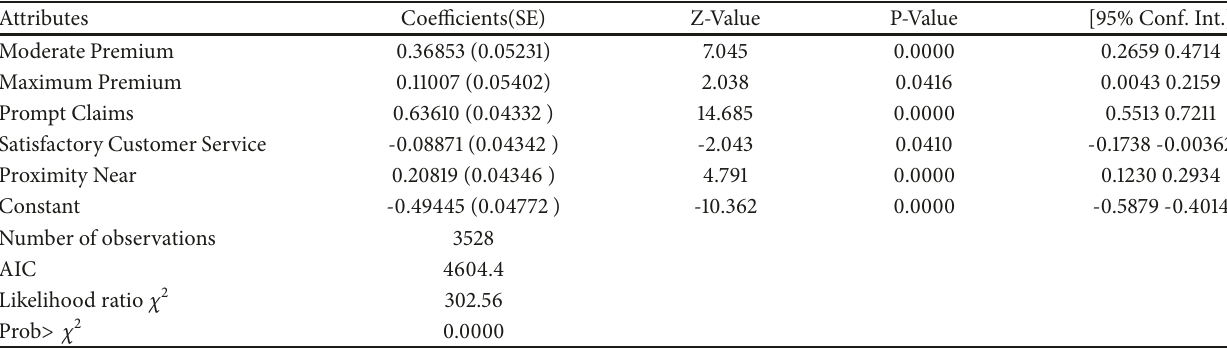
Table 6: Parameter estimates of model based on male policyholders.